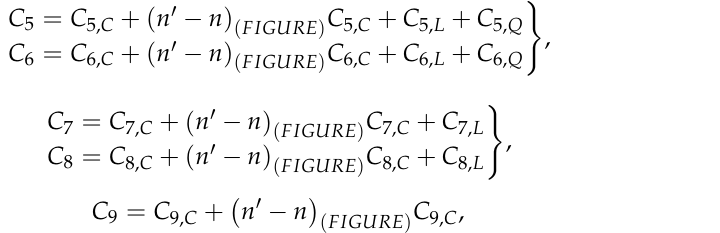
represents the field-constant spherical aberration induced by PM spherical aberration figure